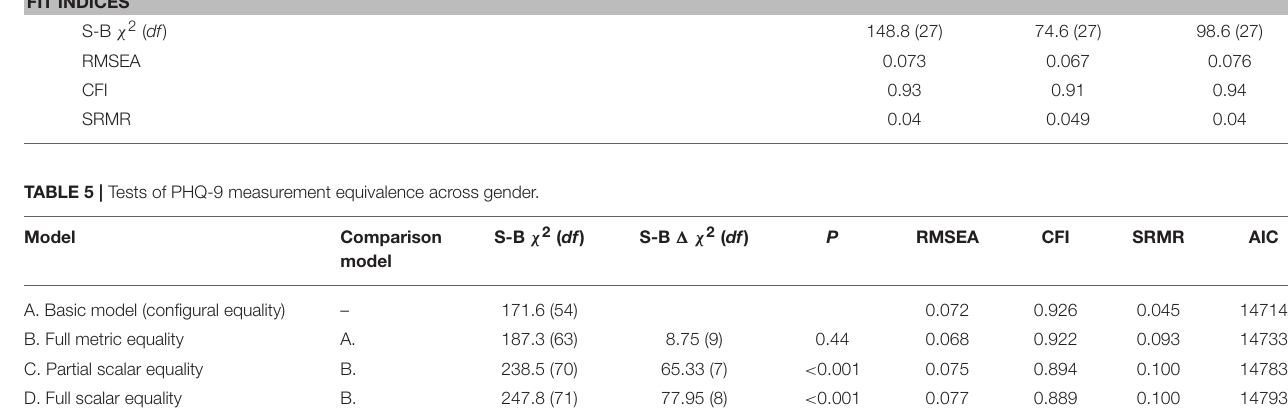
psycho-social characteristics and the PHQ-9